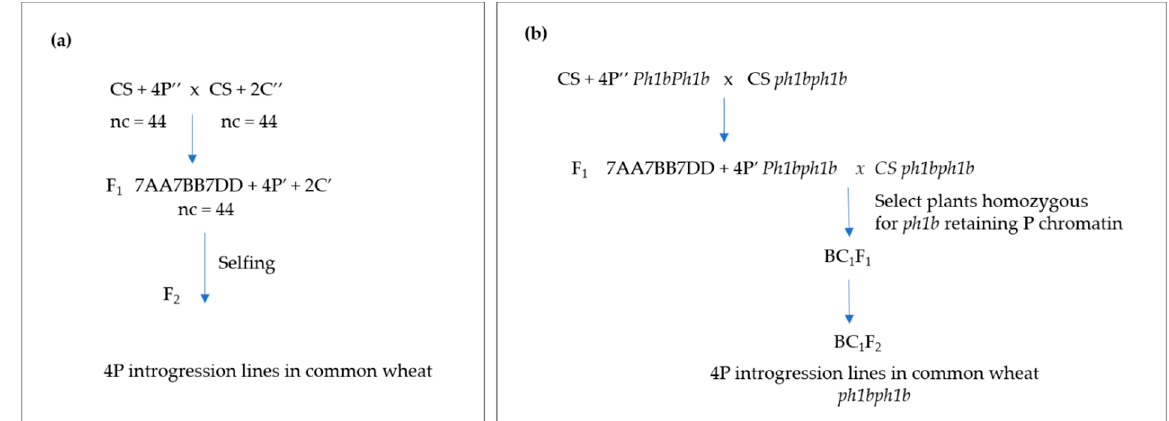
Figure 1. The breeding procedures used to obtain structural changes in A. cristatum chromosomes in wheat background (i.e., 4P introgressions). ( a ) Crosses between the A. cristatum disomic addition lines in CS background and the gametocidal 2C c disomic addition line in CS; ( b ) Crosses between the A. cristatum disomic addition line in CS and the ph1b mutant were developed and backcrosses to the ph1b mutant to develop A. cristatum introgression lines in common wheat in the ph1b mutant background.